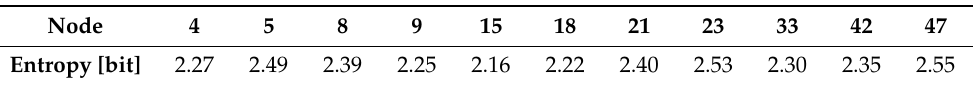
Table 1. Node’s entropy of the dataset 1.